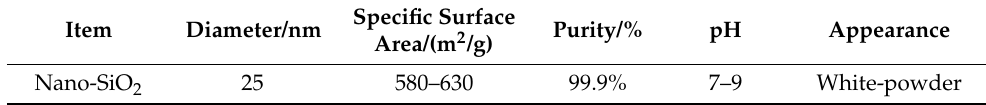
Table 1. Performance of nano-SiO 2 .